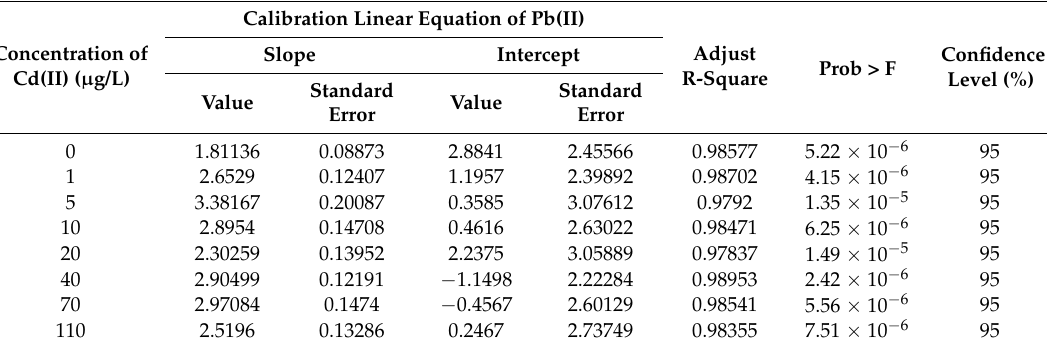
Table 1. Calibration equations of Pb(II) in different concentrations of Cd(II).